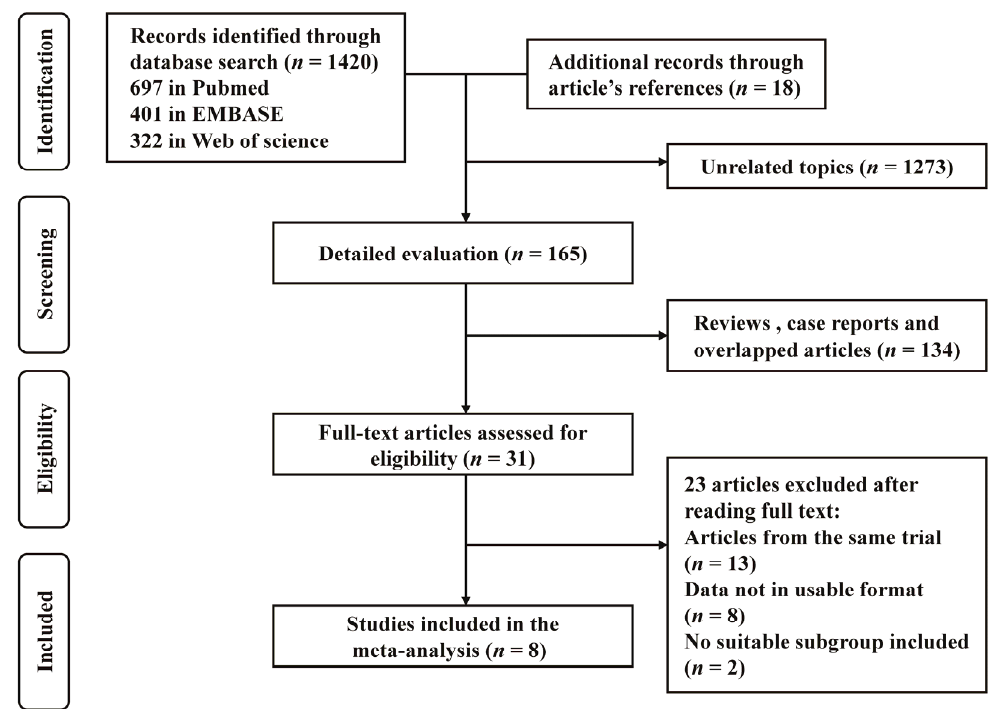
Figure 1. Flow diagram showing the identification of relevant studies in the meta ‐ analysis. The initial 1438 articles were identified, and after 1273 unrelated papers and 134 reviews and case reports were excluded, 31 full texts were assessed for eligibility. Finally, after excluding 23 studies, a total of eight articles were included in this meta ‐ analysis.